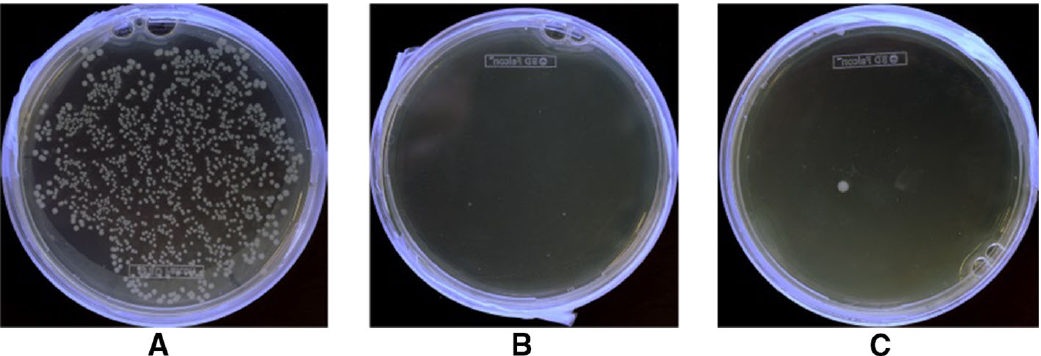
Figure 22. ( a ) Zone of inhibition ( E. coli ) on the number of colony-forming unit (CFU) after 24 h. untreated sample; ( b ) 3% addition of Zinc acetate and ( c ) 3% addition of Zinc acetate-GPTMS (Reproduced from [158], with kind permission of Elsevier).